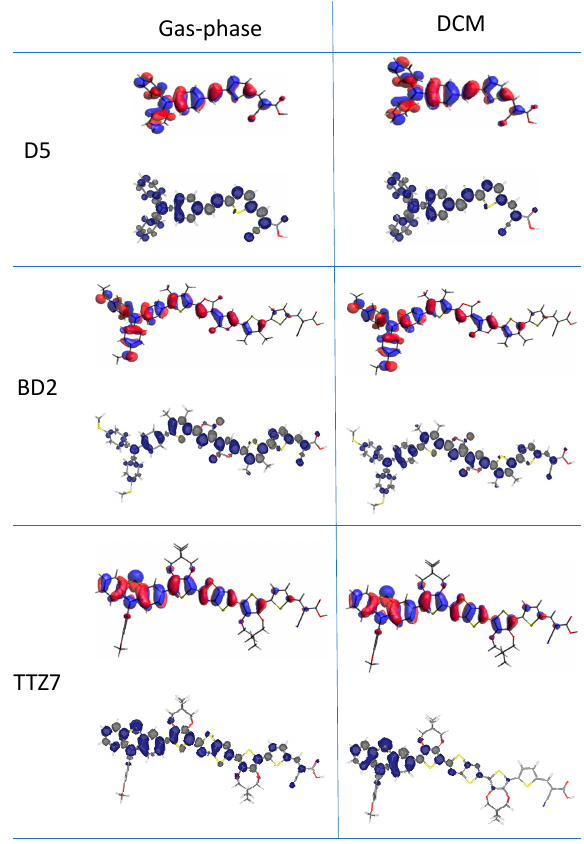
Figure 4. HOMO of the neutral species (top) and the spin density of its cation (bottom) in gas-phase (left) and DCM (right) for D5, BD2 and TTZ7 dyes computed at the MPW1K/6-31+G* level and plotted using Avogadro [29,30] and Chemcraft [31] softwares, respectively.